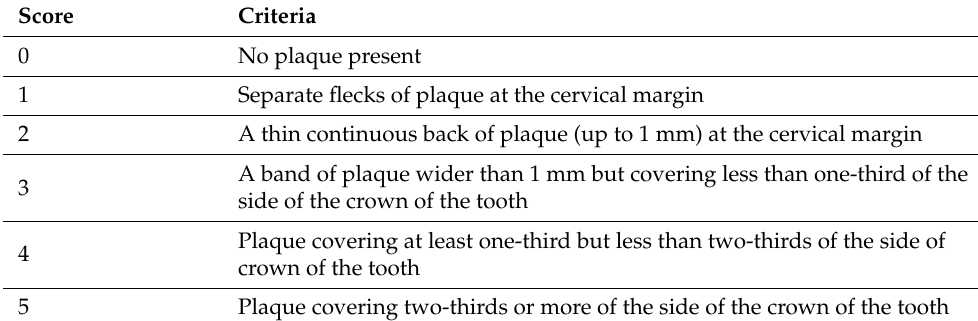
Table 1. A grading system for plaque accumulation Inspired from Ref. [32] with